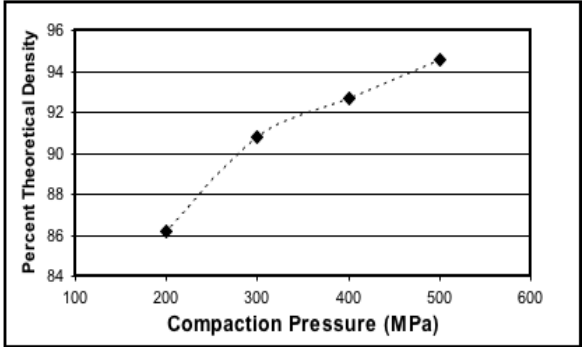
Figure 3. Effect of compaction pressure on green density of AZ31 magnesium